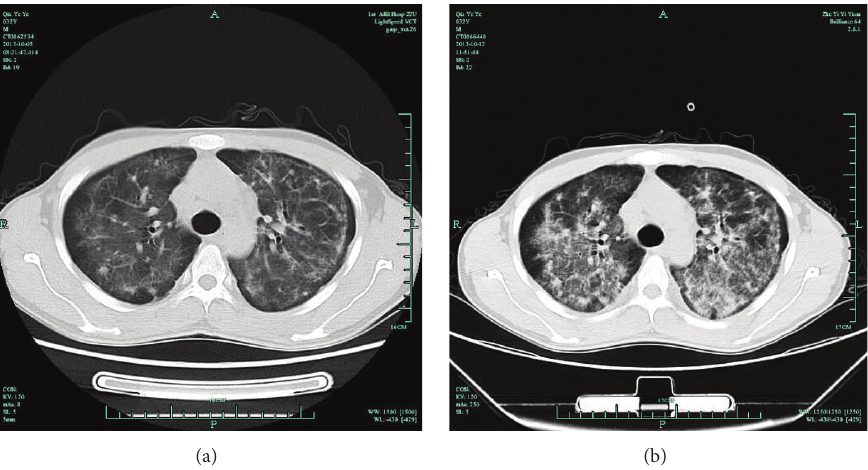
Figure 1: The chest images of computed tomography (CT) scan in the AIDS PCP patient. (a) shows bilateral, symmetric, interstitial, or granular opacities in typical case. (b) shows the opacities are perihilar and diffuse in severe